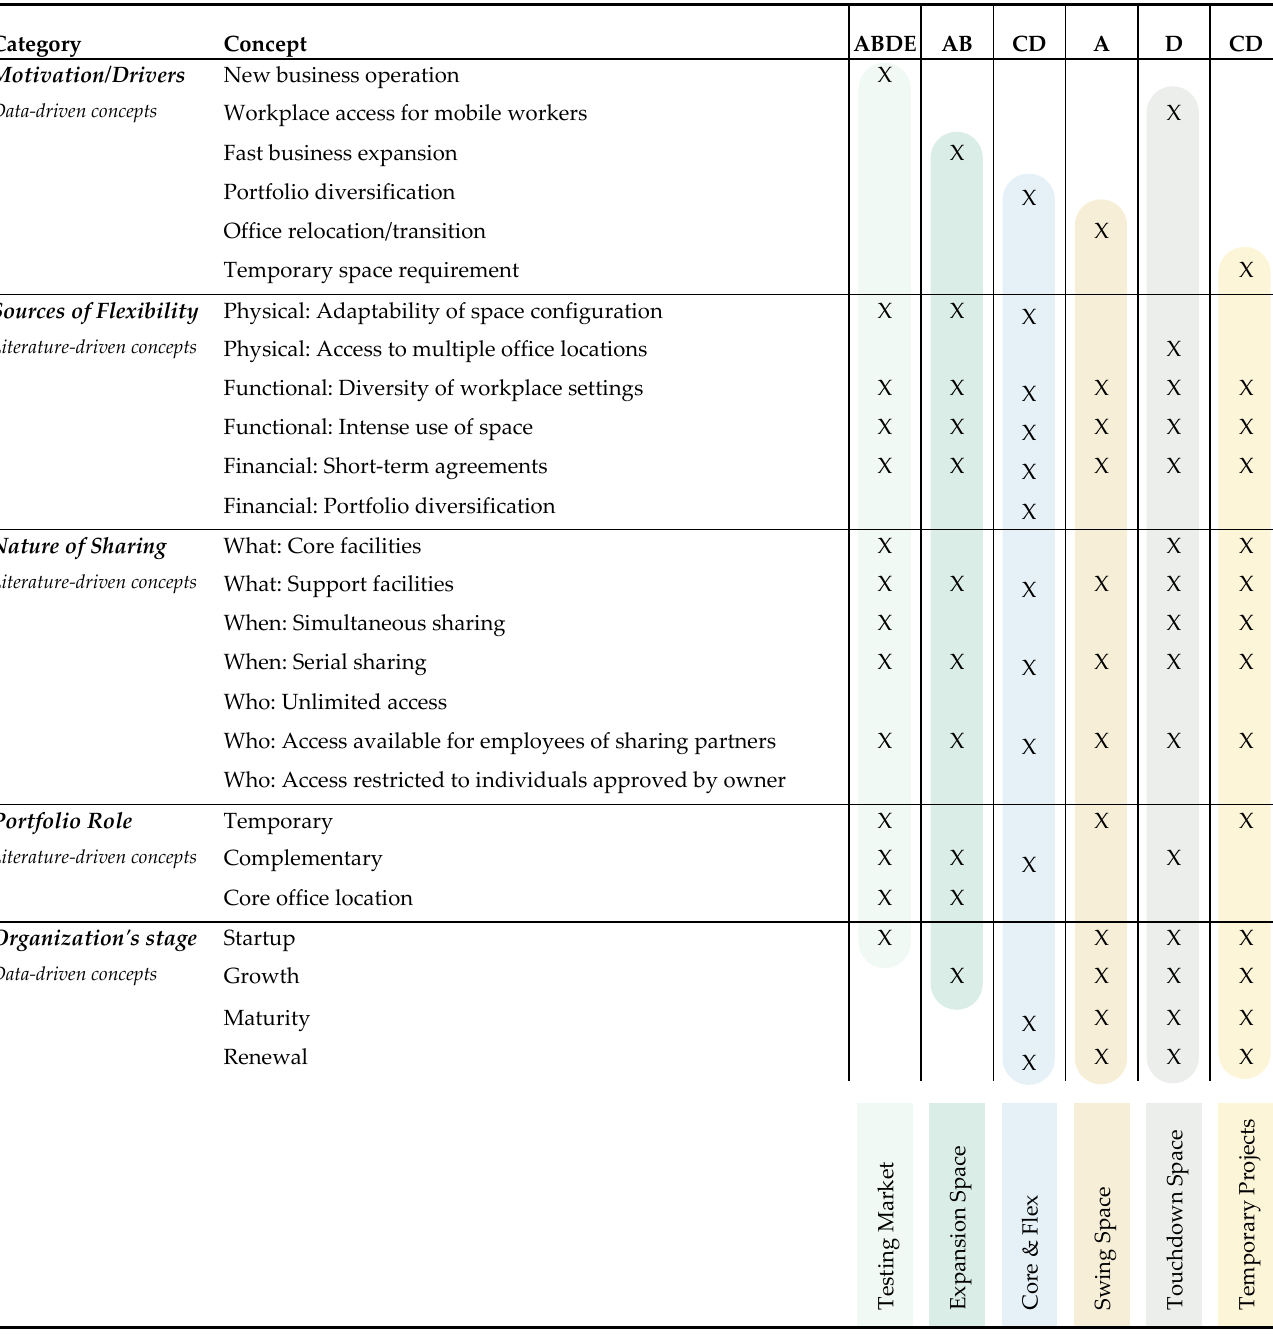
Table 3. Summary of identified co-working strategies in corporate real estate.